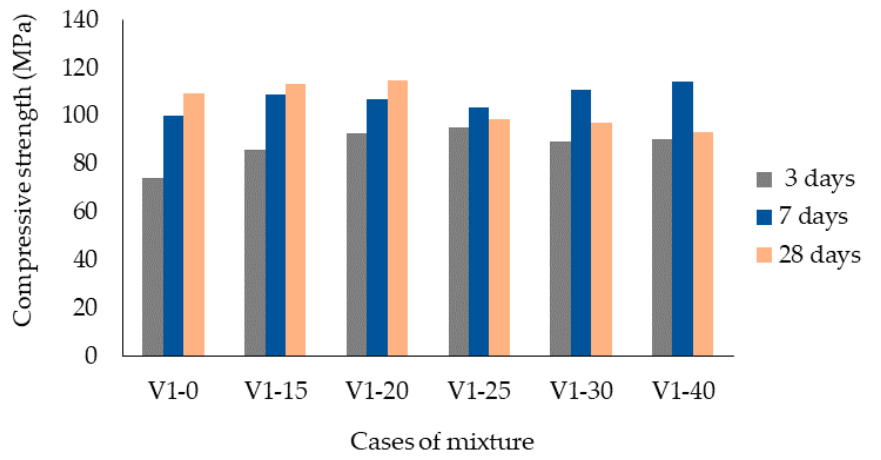
Figure 6. Compressive strength of V1 group.